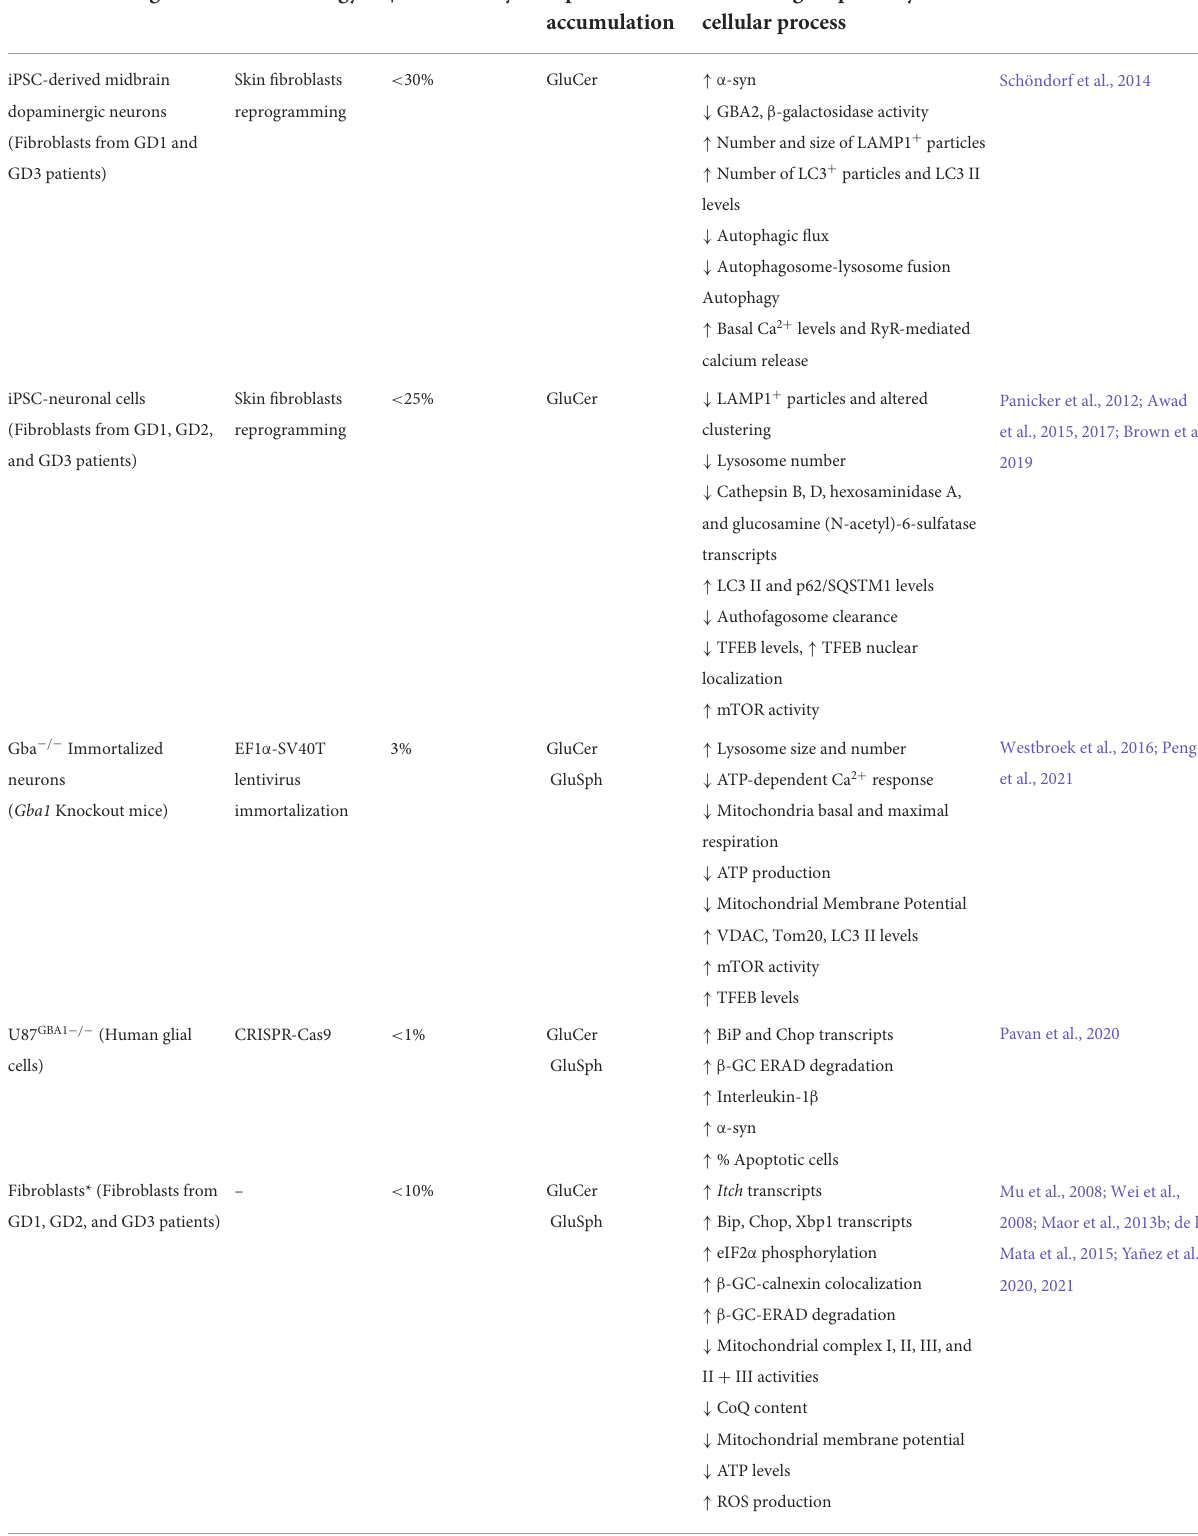
TABLE 1 Cellular models designed for GD